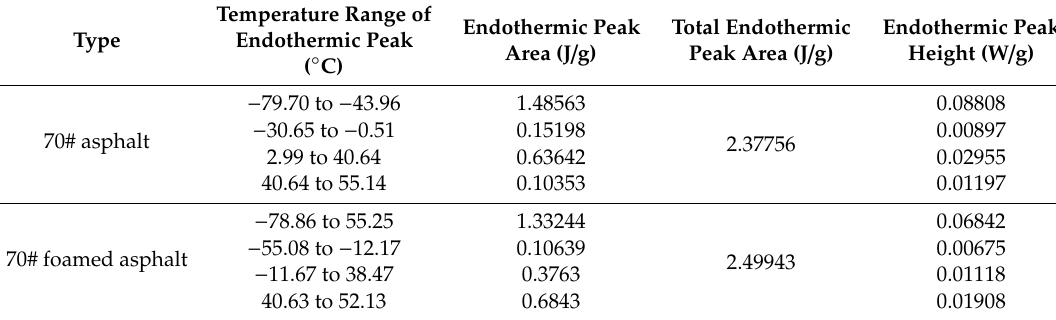
Table 4. Main parameters of the DSC curve of the base asphalt and foamed asphalt.